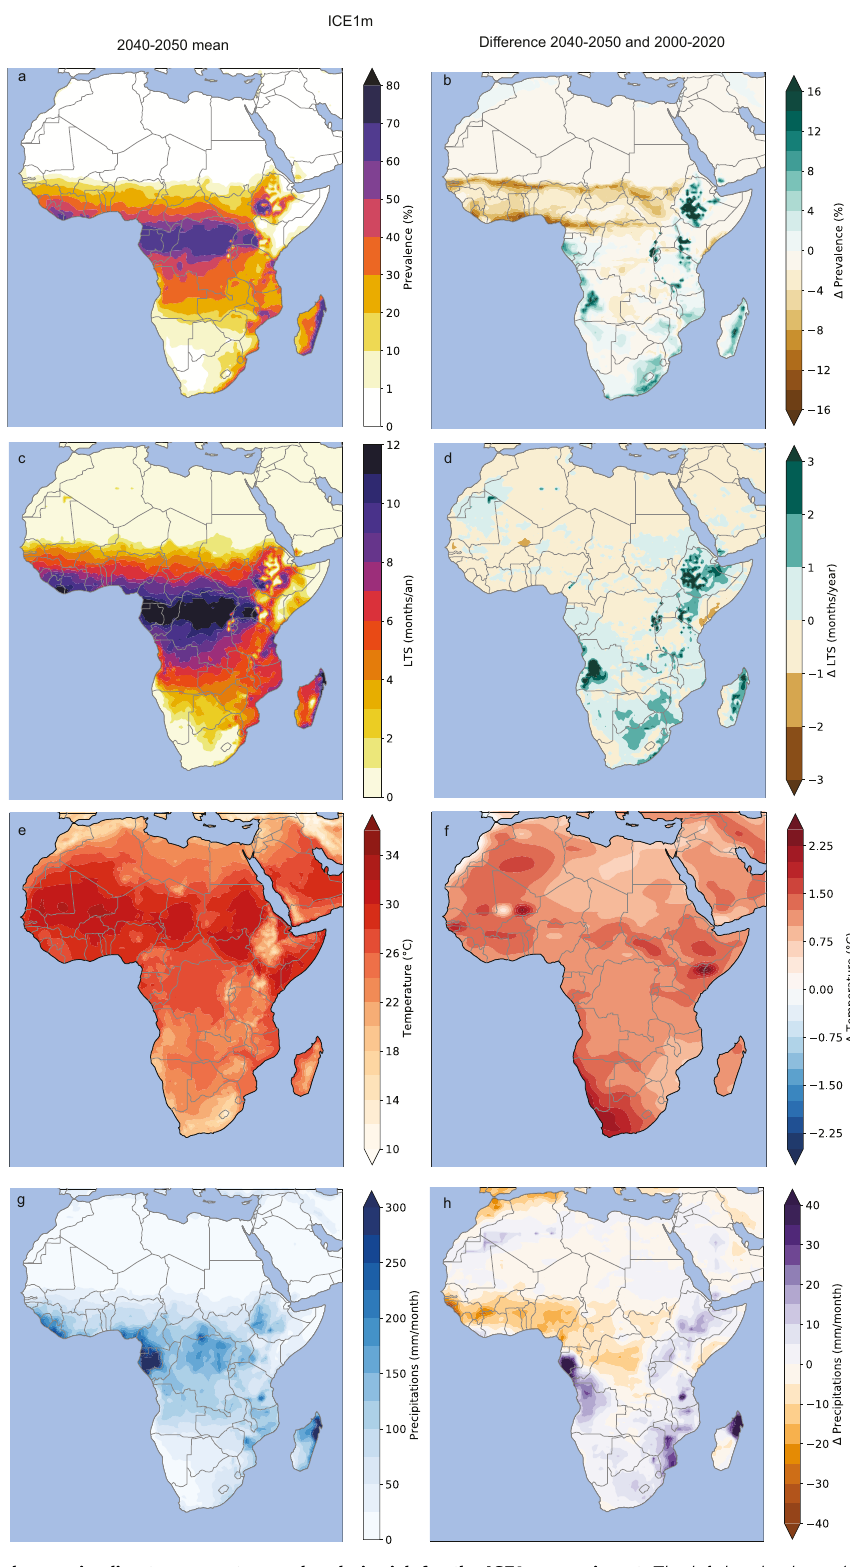
Fig. 3 Mean and future changes in climate parameters and malaria risk for the ICE1m experiment. The left-hand column ( a – c – e – g ) depicts mean patterns for the 2040s and the right-hand column ( b – d – f – h ) shows future differences between the 2040s and 2010s. a , b Simulated malaria prevalence (%) by the LMM. c , d LTS (in months) based on the MARA model. e , f Temperature (°C) and g , h precipitation (mm.month − 1